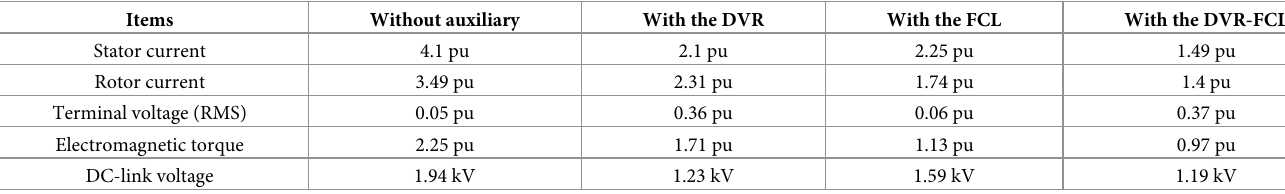
Table 2. Comparison of various methods on the DFIG subject to the symmetrical fault. Items Without auxiliary With the DVR With the FCL With the DVR-FCL Stator current 4.1 pu 2.1 pu 2.25 pu 1.49 pu Rotor current 3.49 pu Terminal voltage (RMS) 0.05